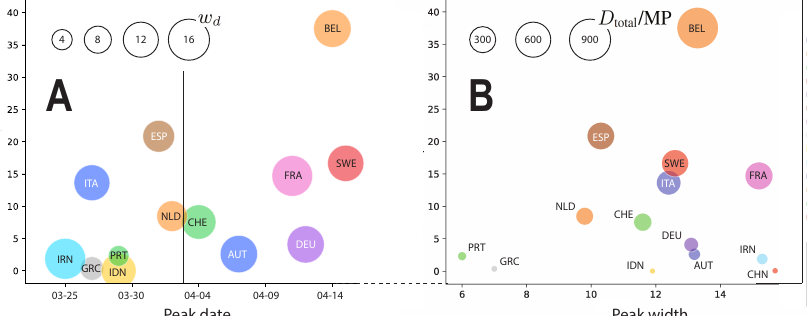
Figure 4. ( A ) Plot of the fitted GM parameters w d , t d,max , and d max tabulated in Table 1. The horizontal lines mark the day of this study, April 2. China is missing in this plot as its t d,max occurred on February 17 according to our calculation. ( B ) Peak daily number of fatalities per 1 million inhabitants, i.e., d max divided by the number of inhabitants times 10 6